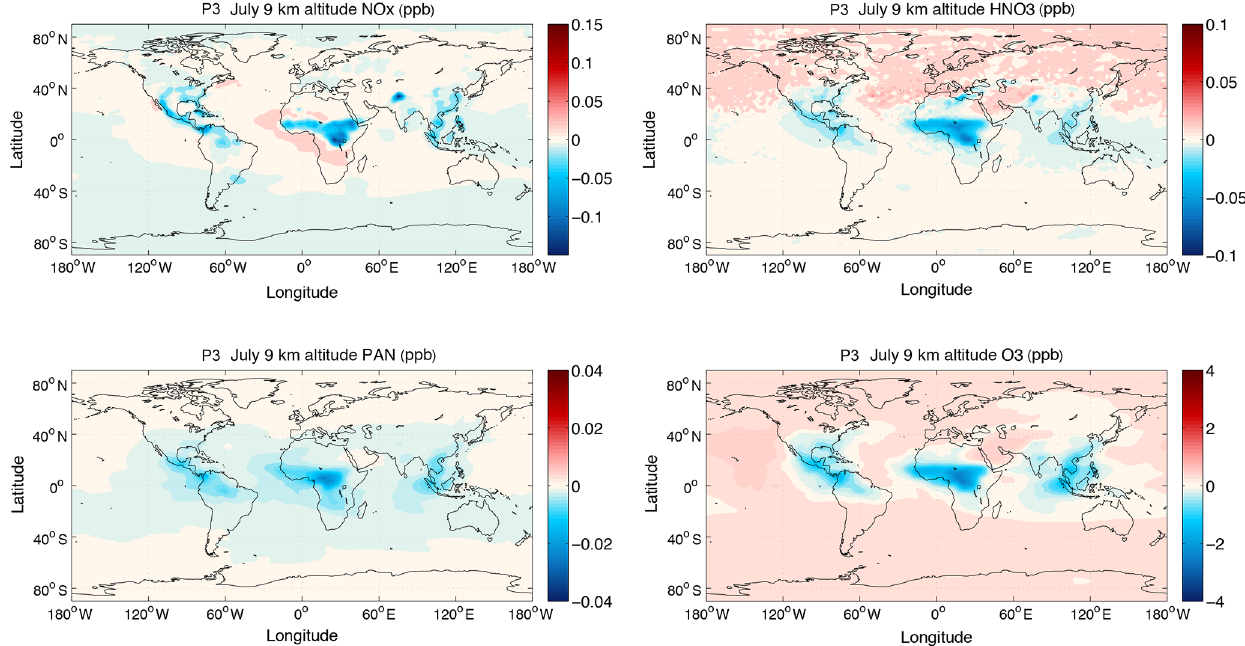
Figure 5. Geographical distributions of NO x , HNO 3 , PAN, and O 3 variations (in ppb) at 9km altitude for July from the absolute difference (P3) between P1 and BC experiments. P1 was performed using τ and K eff determined with D h = 15m 2 s − 1 and NO mean